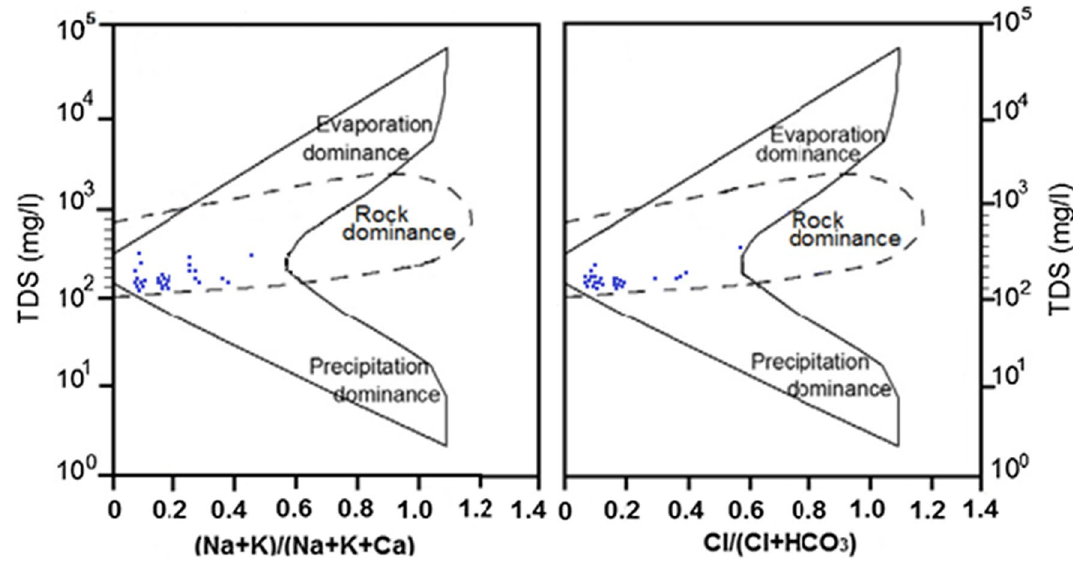
Fig. 4 Gibbs ratio for groundwater in